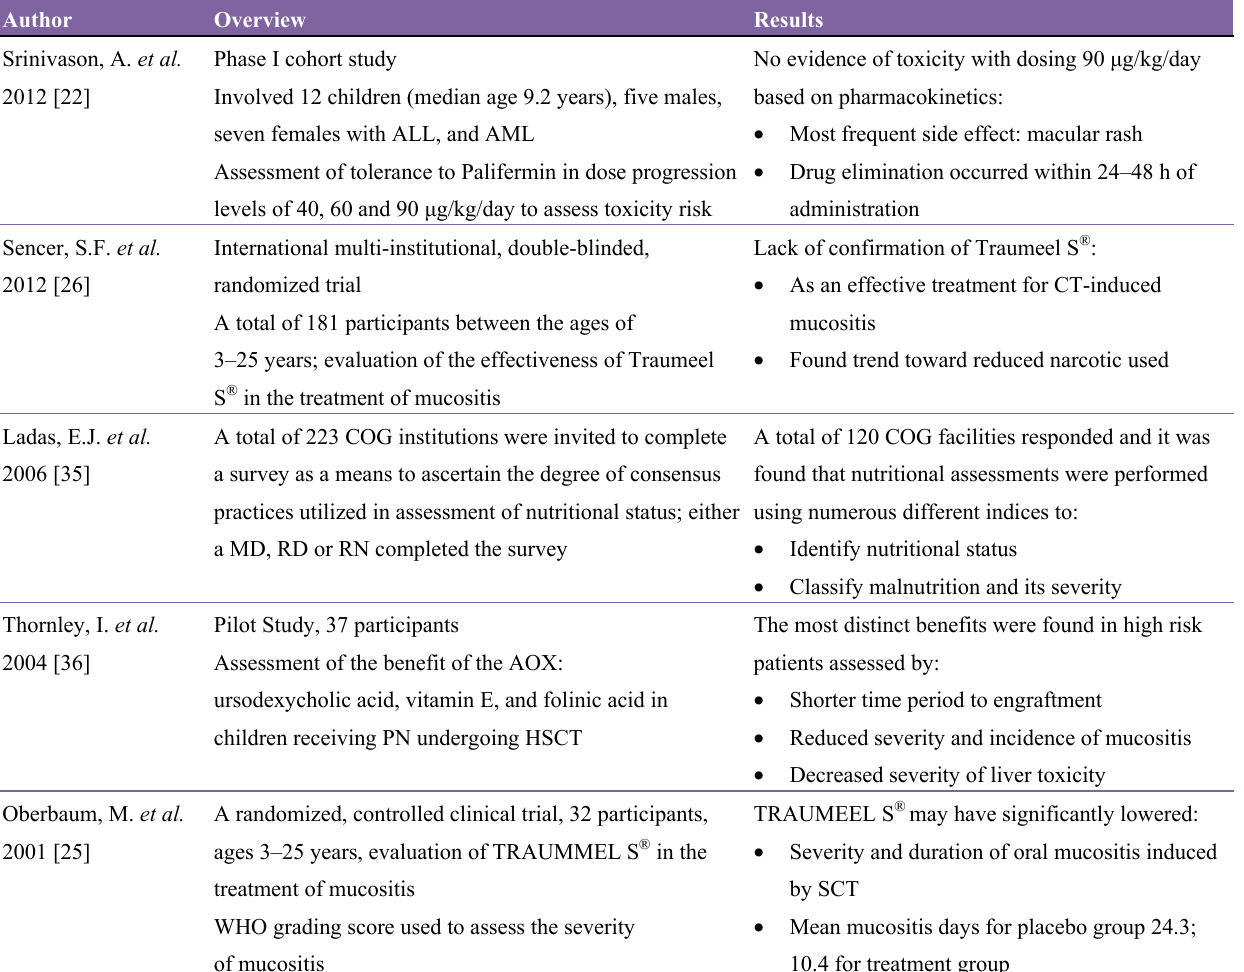
Table 1. Overview of nutrition-related pediatric oncology studies—mucositis and nutrition care practices.